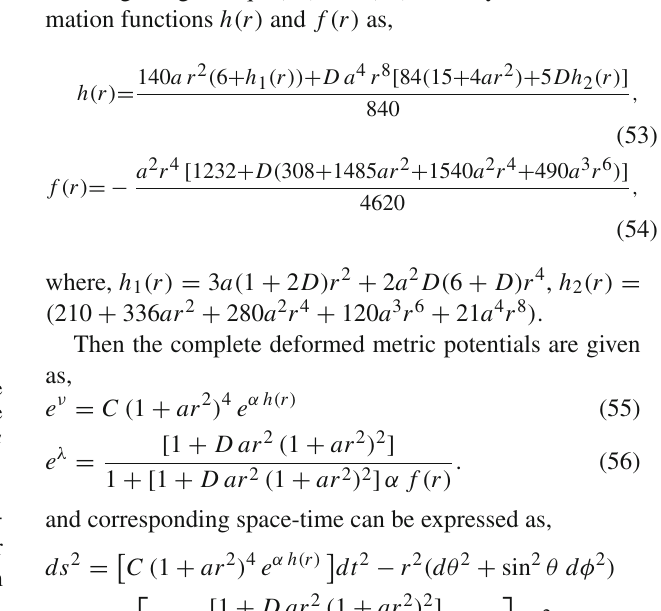
conservation Eq. (42) by taking a suitable form of deforma- tion function h ( r ) . As we see that the Eq. (42) is a first order ordinary differential equation which can be written in form of integral